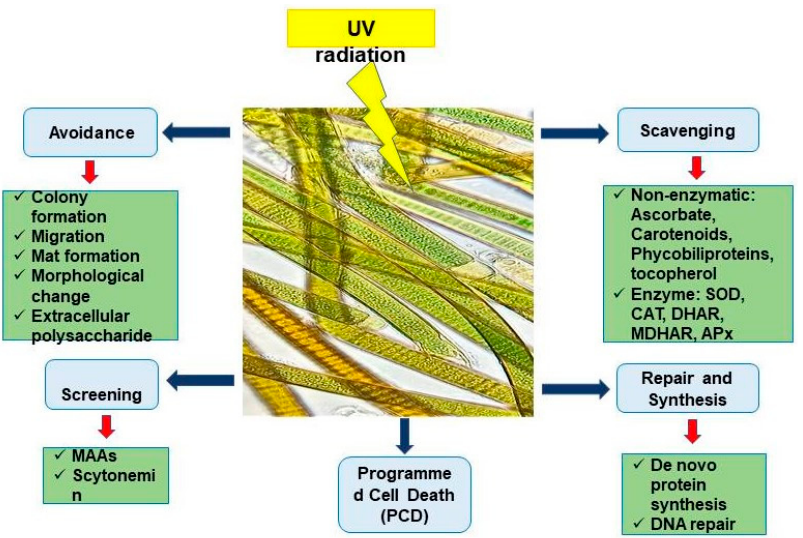
Figure 2. The overview of cyanobacterial survival strategies to cope with Ultraviolet radiation.